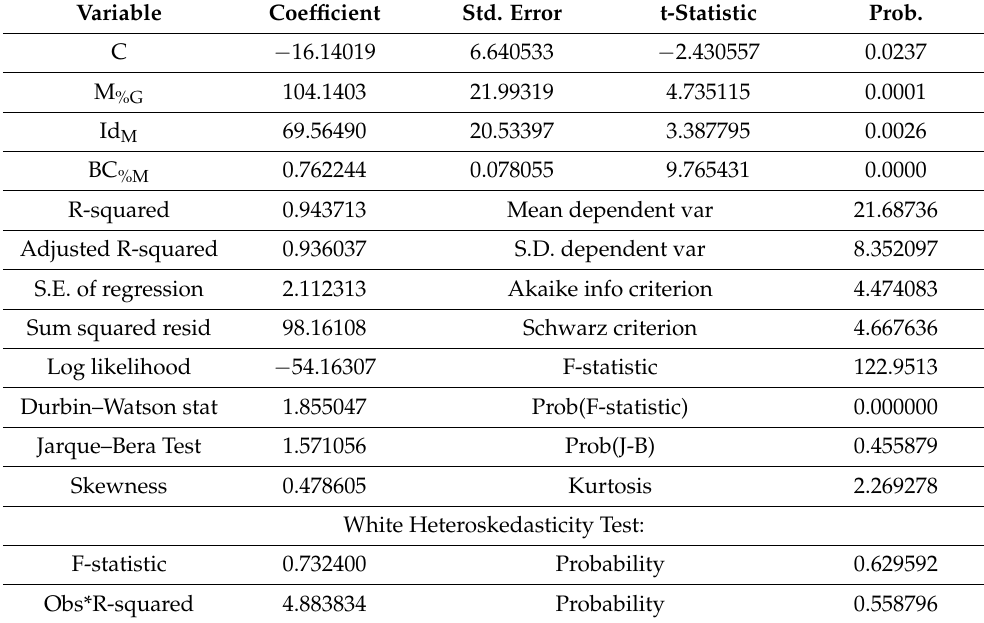
Table 10. S FDI_in(%GDP) model by M %G , Id M and BC %M for